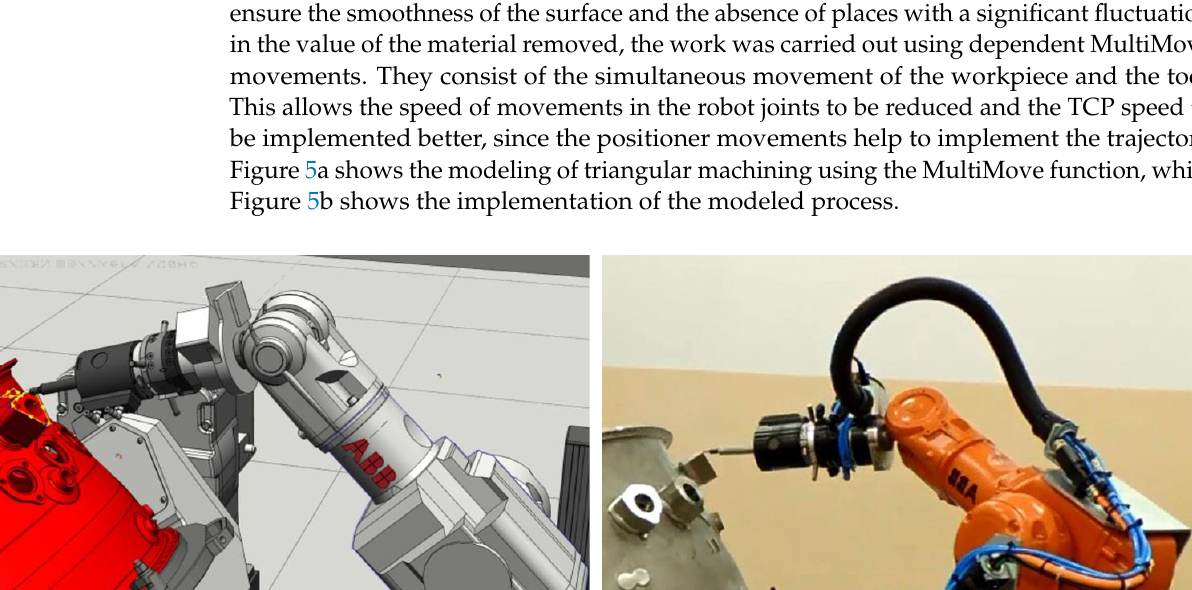
Figure 4. Model of the machining process in RobotStudio: ( a ) nominal trajectory; ( b ) offset trajectory.